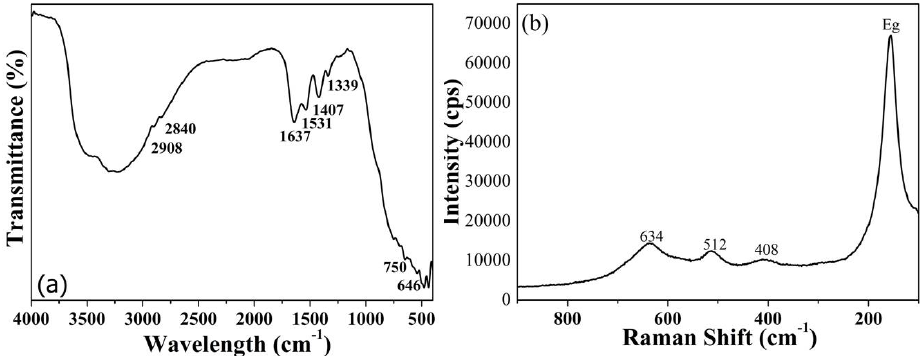
Figure 3. ( a ) FTIR and ( b ) Raman spectra of TiO 2 nanoparticles.